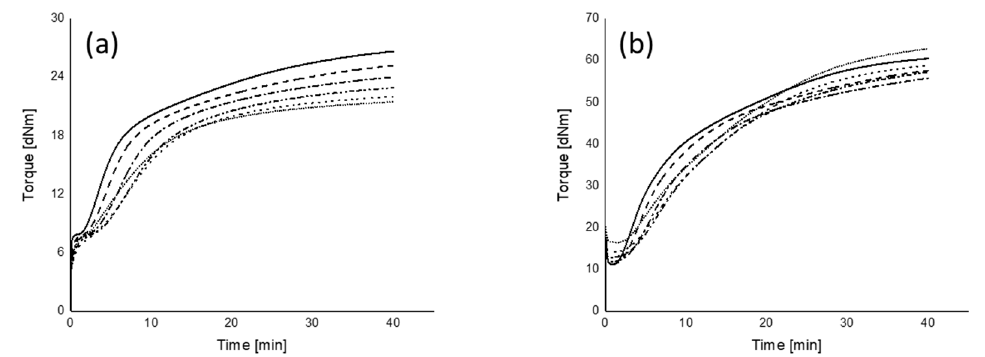
Figure 10. Rheograms of mixing procedure A: ( a ) 0.5° (~7% of strain) and ( b ) 3° (~42% of strain);